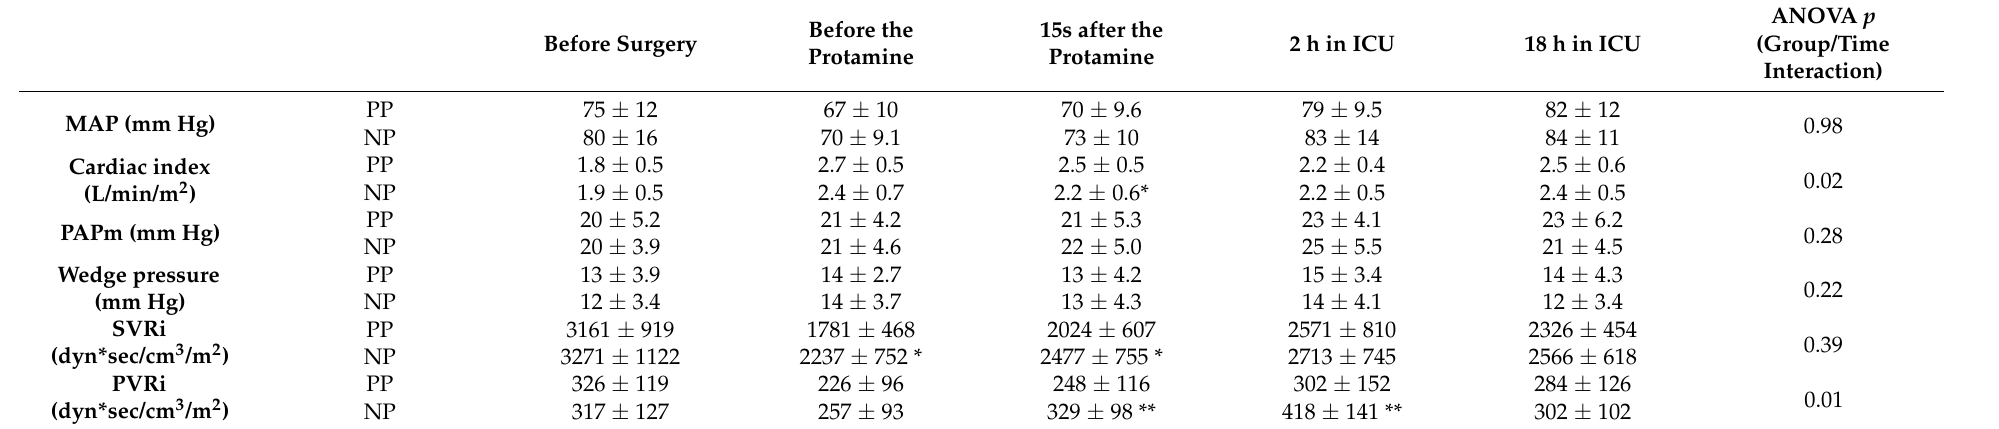
Table 3. Hemodynamic profile before and after cardiopulmonary